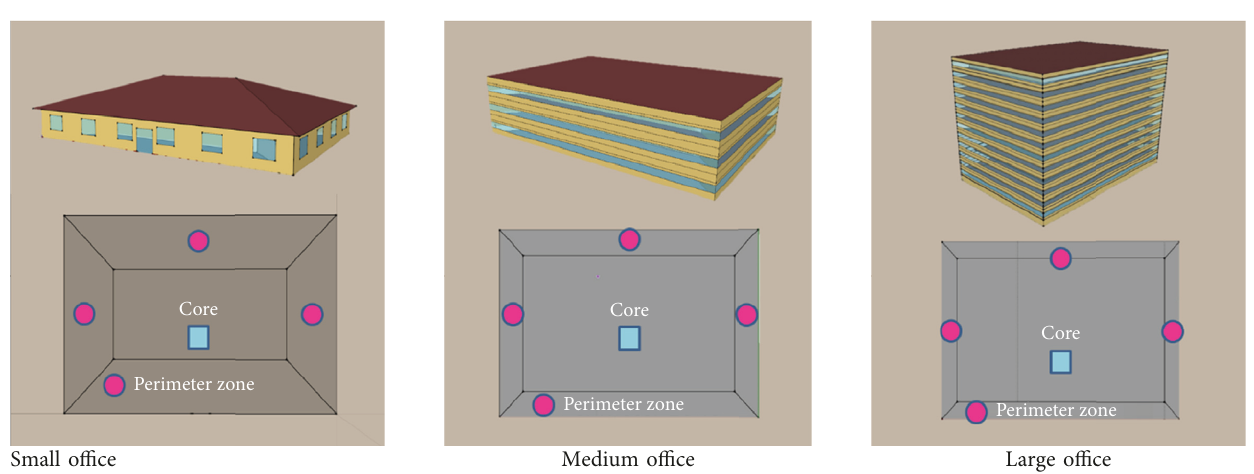
Table 2: DOE commercial reference